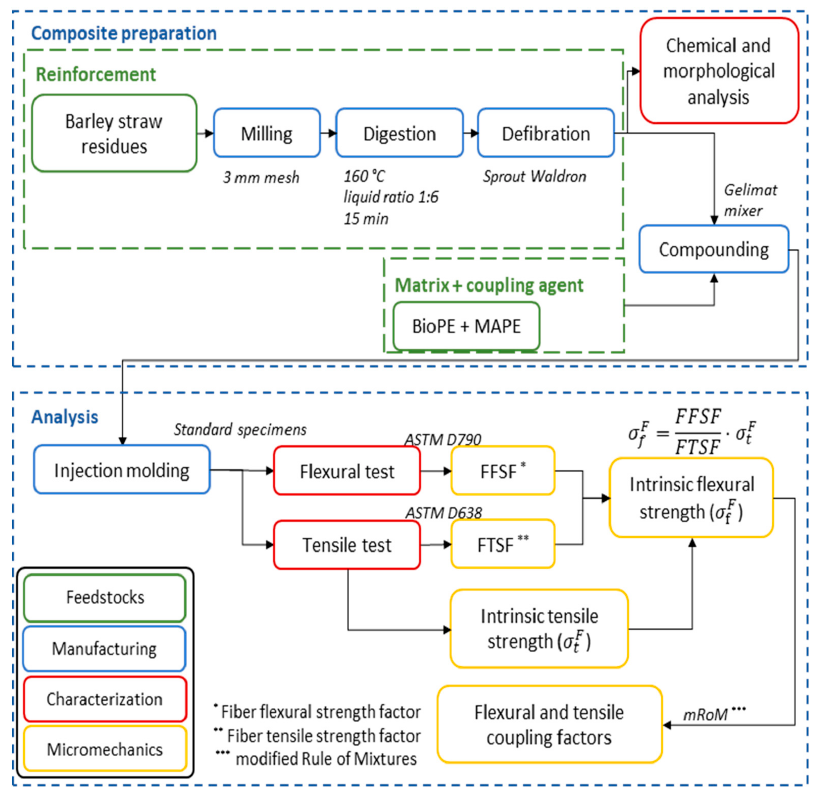
Figure 9. Flowchart of the current investigation.